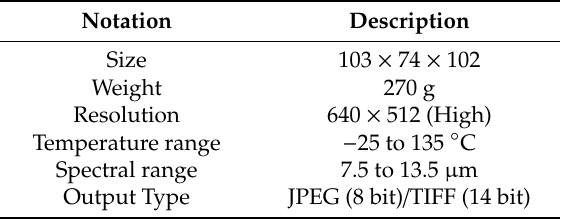
Figure 2. Images of ( a ) the unmanned aerial vehicle (UAV) (M210 RTK V2), and ( b ) the thermal infrared sensor (Zenmuse XT). Table 1. FLIR Zenmuse XT parameters